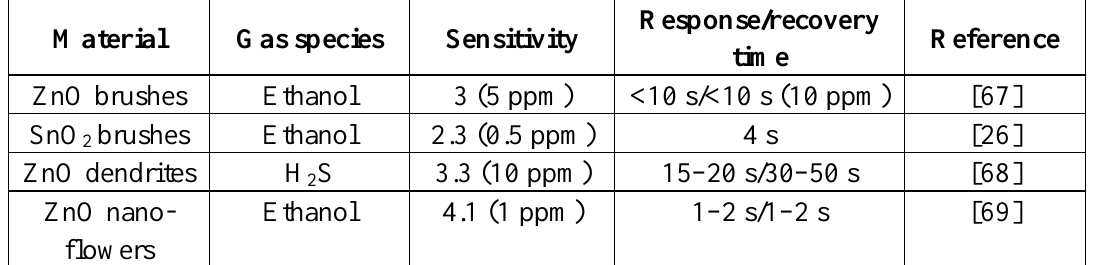
Table 2. Gas sensing properties of metal oxide nanostructure special morphology.